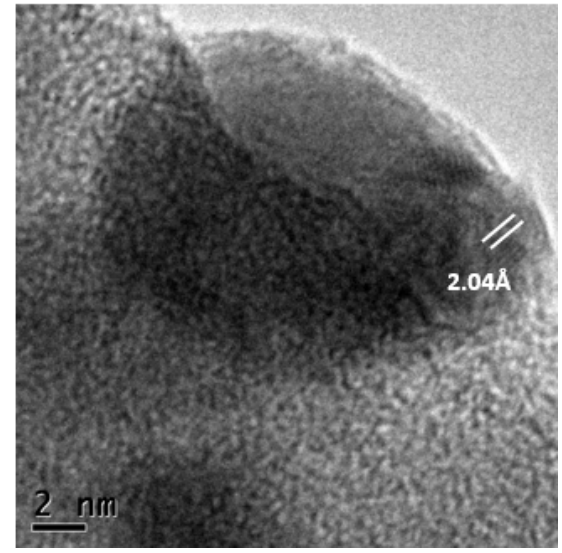
Figure 3. HRTEM micrograph of Ag-nanobiocomposite 5% Ag / bovine bone